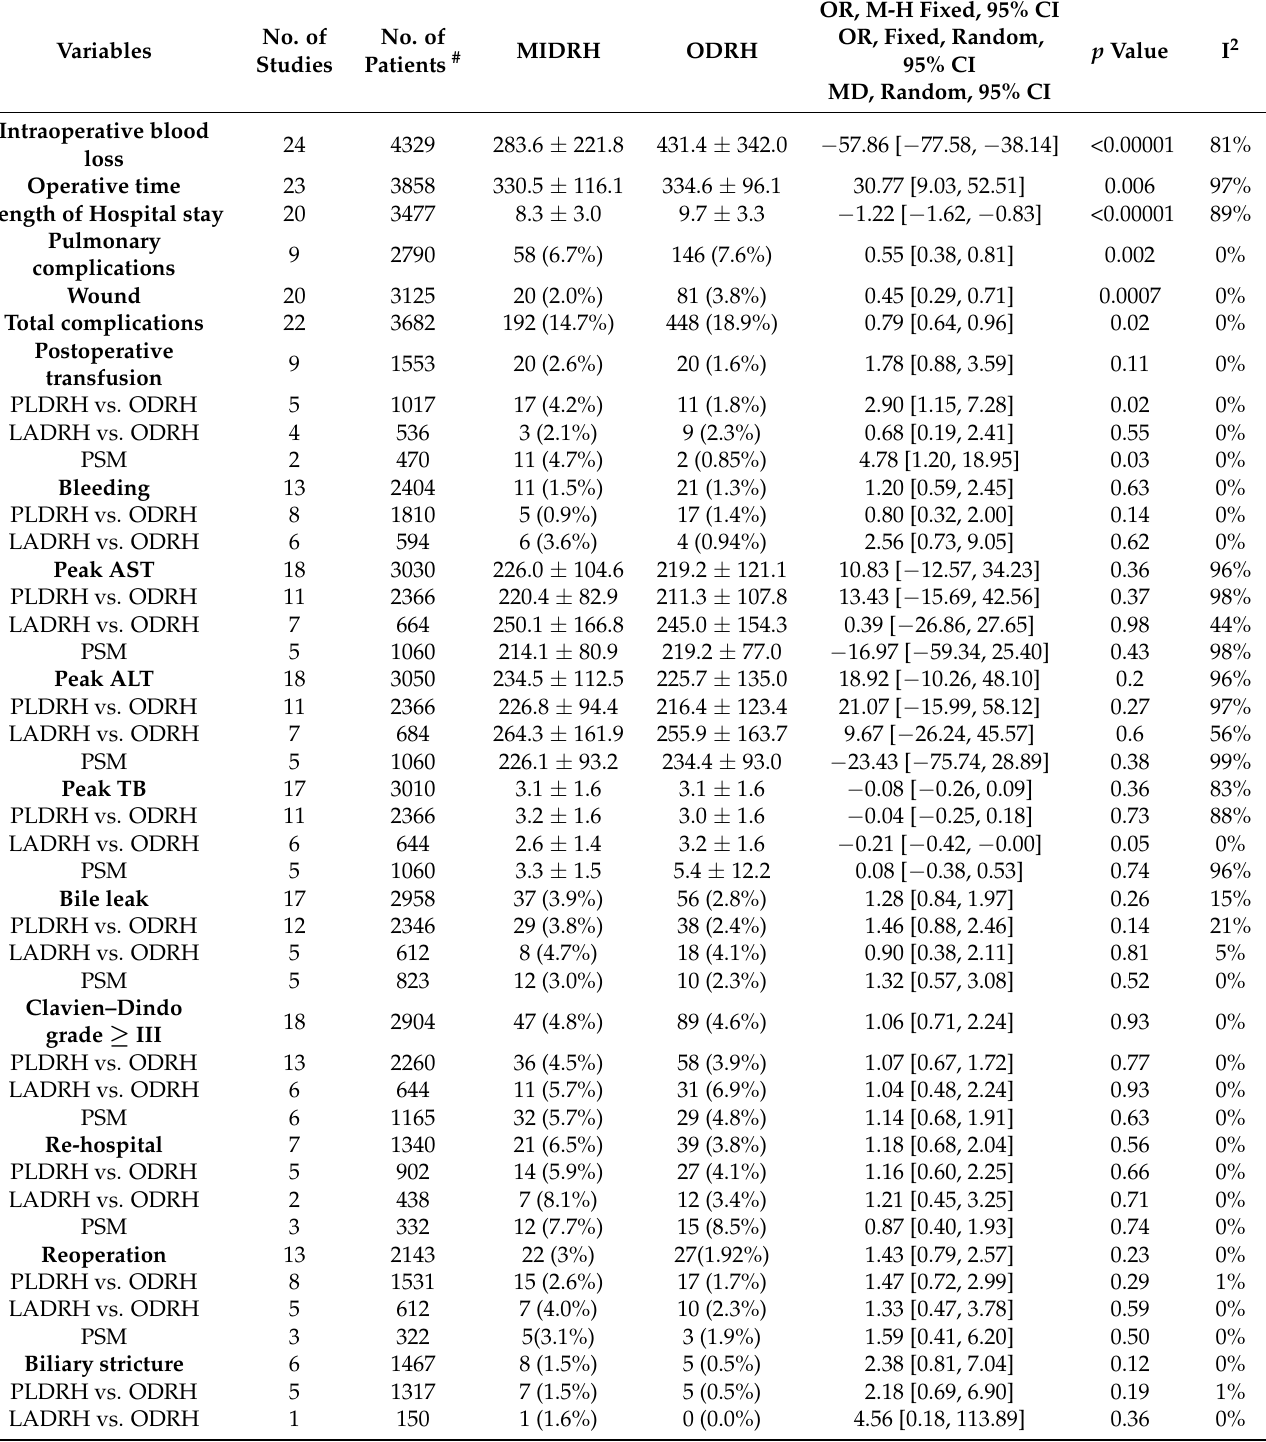
Table 3. Comparison of patient outcomes between MIDRH and ODRH